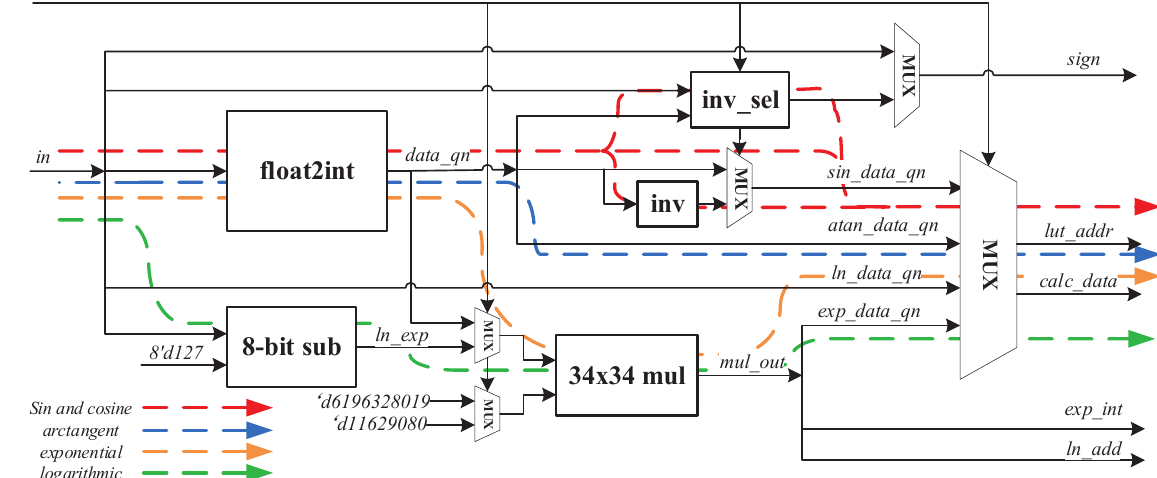
Figure 7. Preprocessing